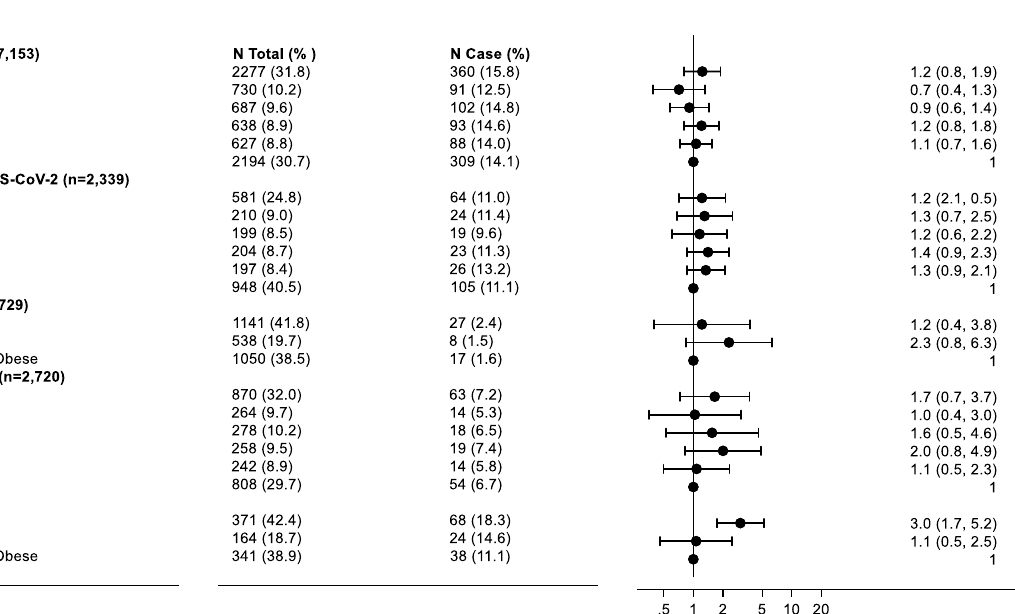
Fig. 3 Forrest plot of adjusted logistic regression coefficients for age first obese and COVID-19 outcomes in BCS70. Analysis is adjusted for sex, social class at birth, housing tenure age 5 and cognitive abil- ity age 10. For self-reported COVID-19 and antibody-confirmed SARS-CoV-2 infection the reference category is “no COVID-19” and “no infection”, respectively. For hospital admission and contact